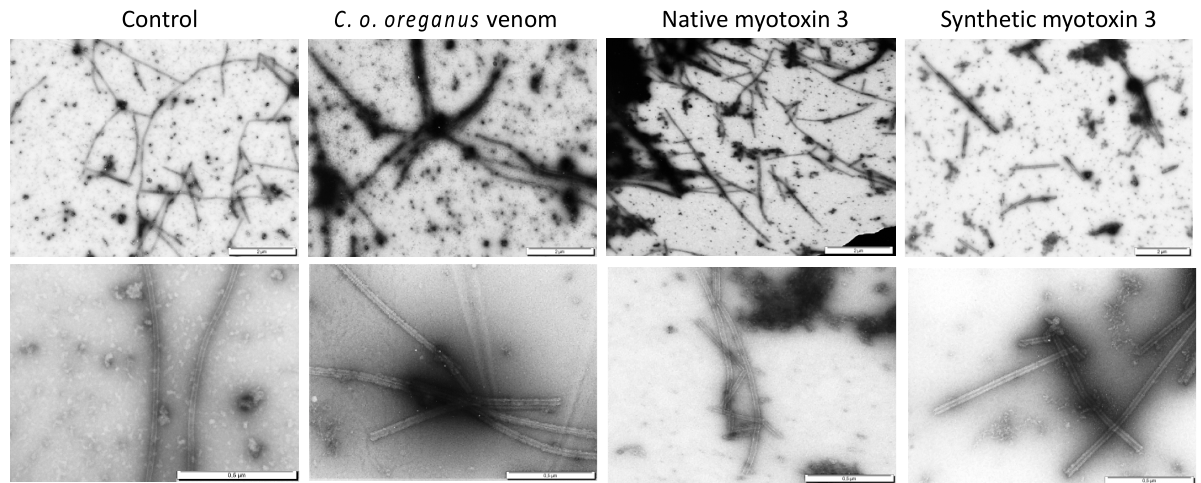
Figure 6. Microtubules assembled in the presence of myotoxin 3 and C. o. oreganus venom. Tubulin was allowed to polymerize at 37 °C in the absence (control) or in the presence of crude venom, native or synthetic myotoxin-3. Microtubules were then stained and observed by electron microscopy. Scale bars = 2 µm (upper panels), 0.5 µm (lower panels).